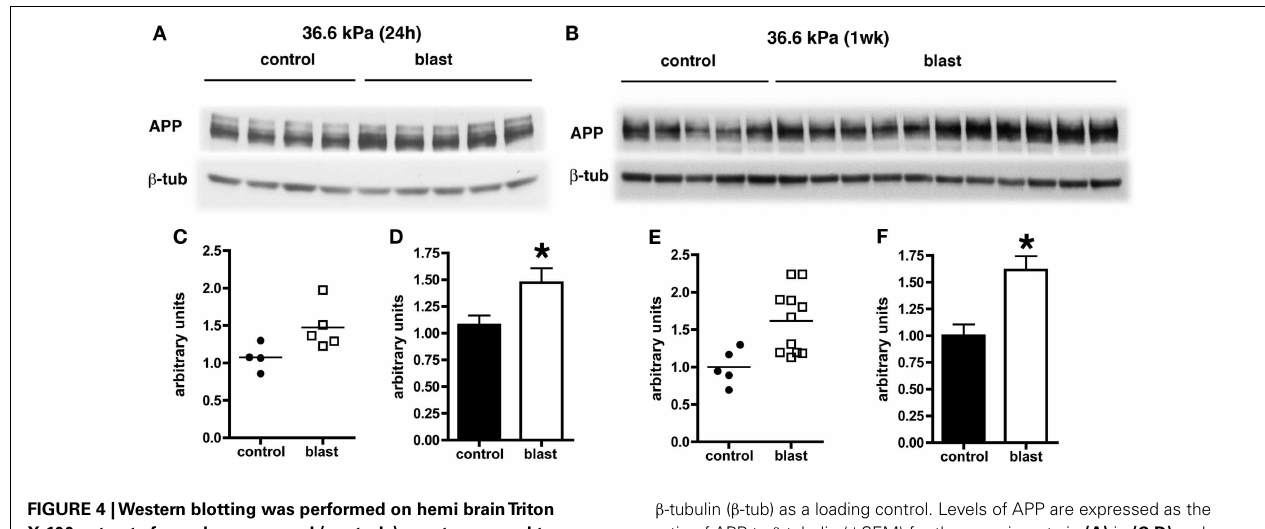
FIGURE 4 |Western blotting was performed on hemi brainTriton X-100 extracts from sham exposed (controls) or rats exposed to 36.6kPa blast injury harvested at 24h (A) or 1week post-blast exposure (B). The top panel in each set shows blotting with an antibody that recognizes APP. In the lower panels the blots were reprobed for